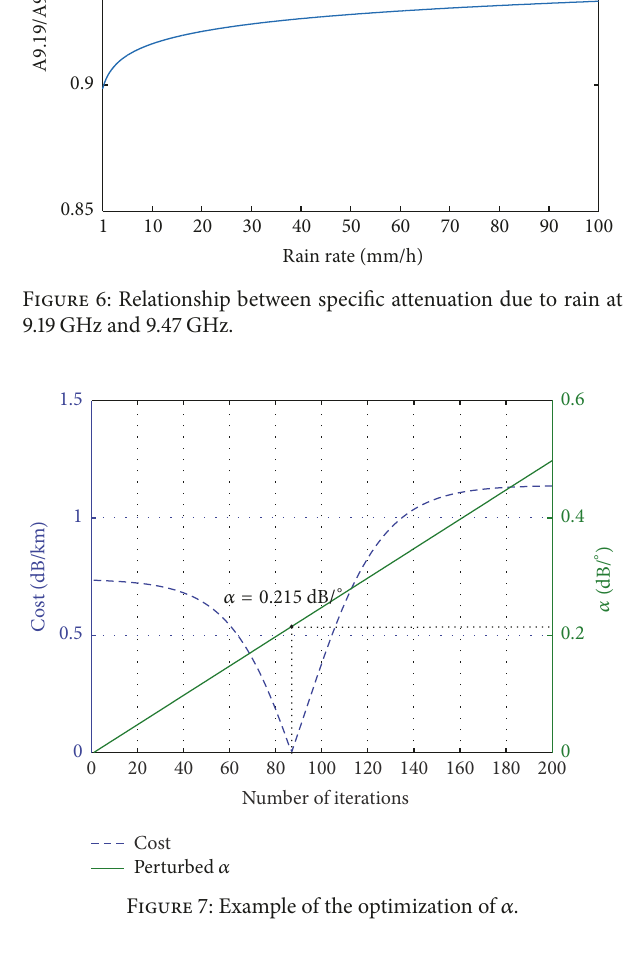
Figure 7: Example of the optimization of 𝛼 .